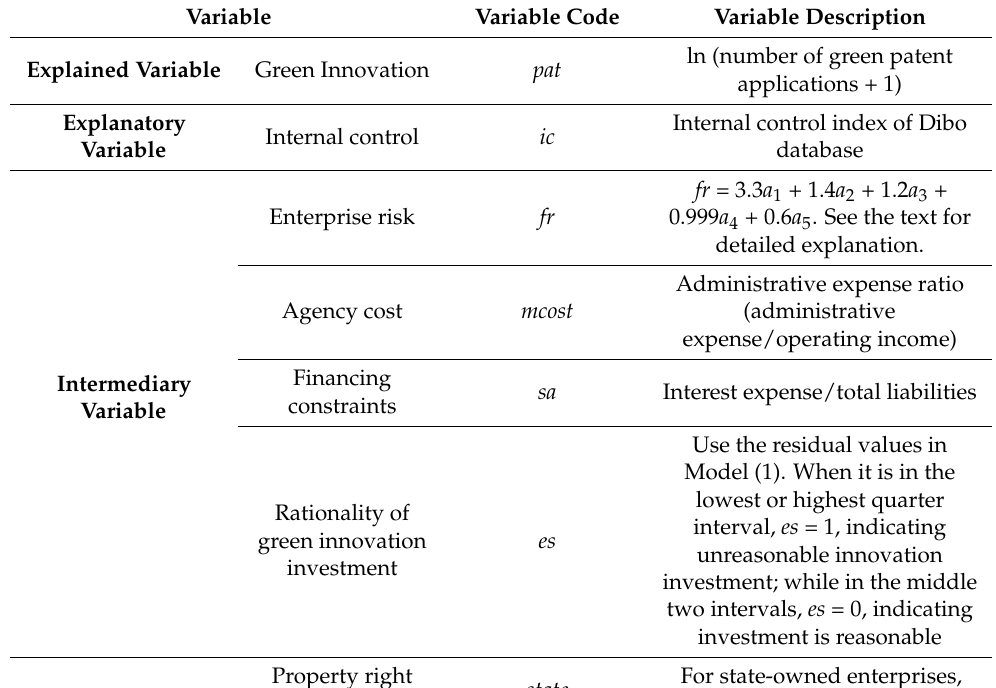
Table 1. Definitions of